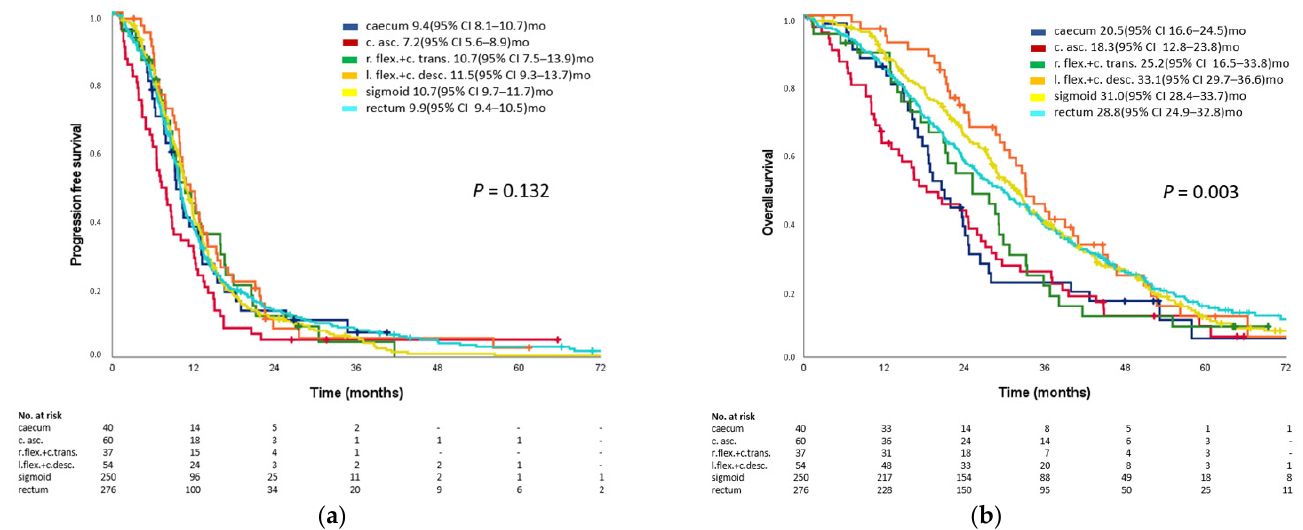
Figure 1. Kaplan-Meier estimates of efficacy endpoints. ( a ) Kaplan–Meier estimates of progression -free survival and overall survival according to exact PTL in RAS/BRAF wild-type tumors. ( b ) Kaplan–Meier estimates of overall survival according to exact PTL in RAS/BRAF wild-type tumors. Legend: 95% CI = confidence interval; c. asc. = ascending colon; c. desc. = descending colon; c. trans = transverse colon; l. flex/l. fl. = left flexure; r. flex./r. fl. = right flexure; no. = number; OS = overall survival; PFS = progression-free survival. p -values: log-rank test.